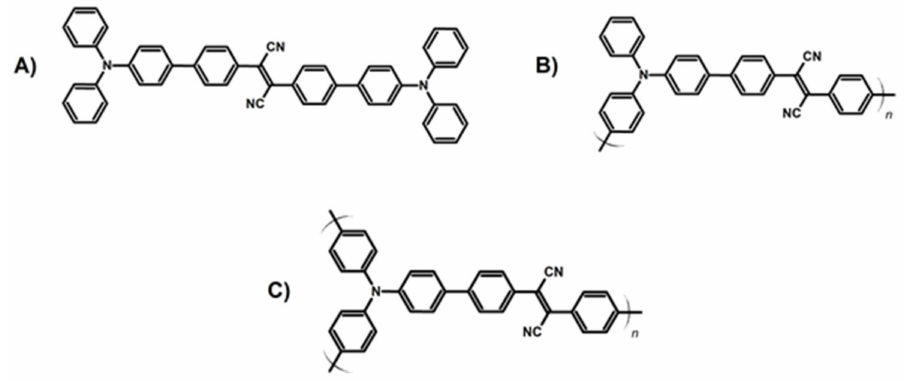
Figure 11. Schematic representation of CMPs based on triphenylamine and fumaronitrile with the increased conjugation lengths from ( A – C ) (investigated in